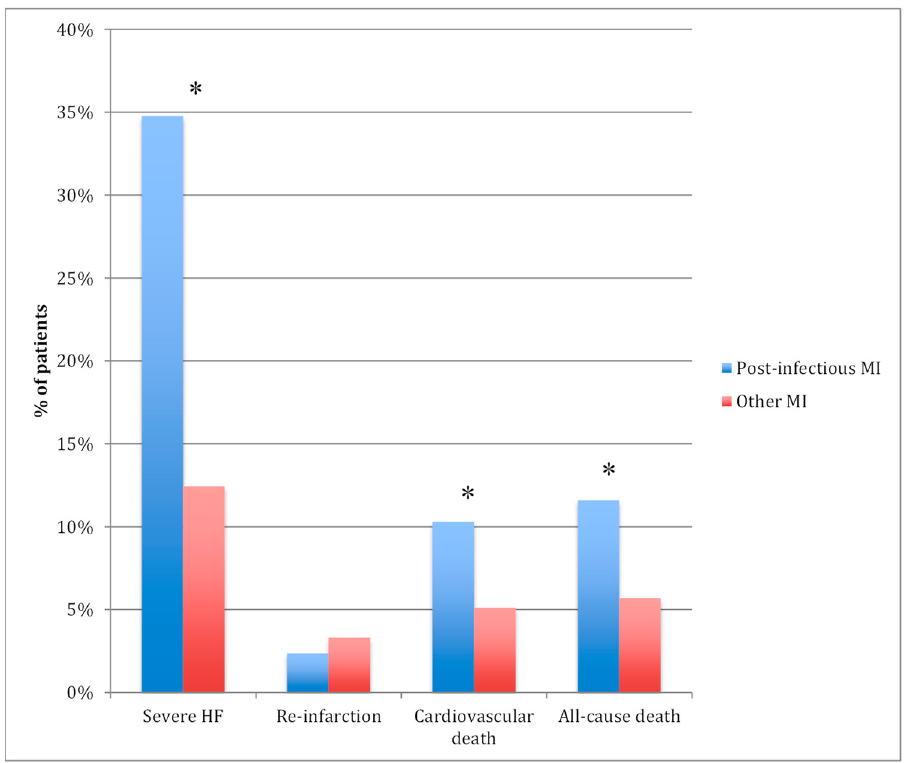
Figure 5. In-hospital outcomes. * p < 0.05; HF: heart failure; MI: myocardial infarction.